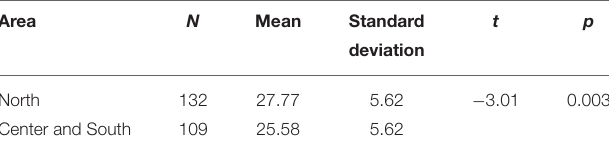
TABLE 8 | Areas of spent isolation (South, Center and North of Italy) and PSS